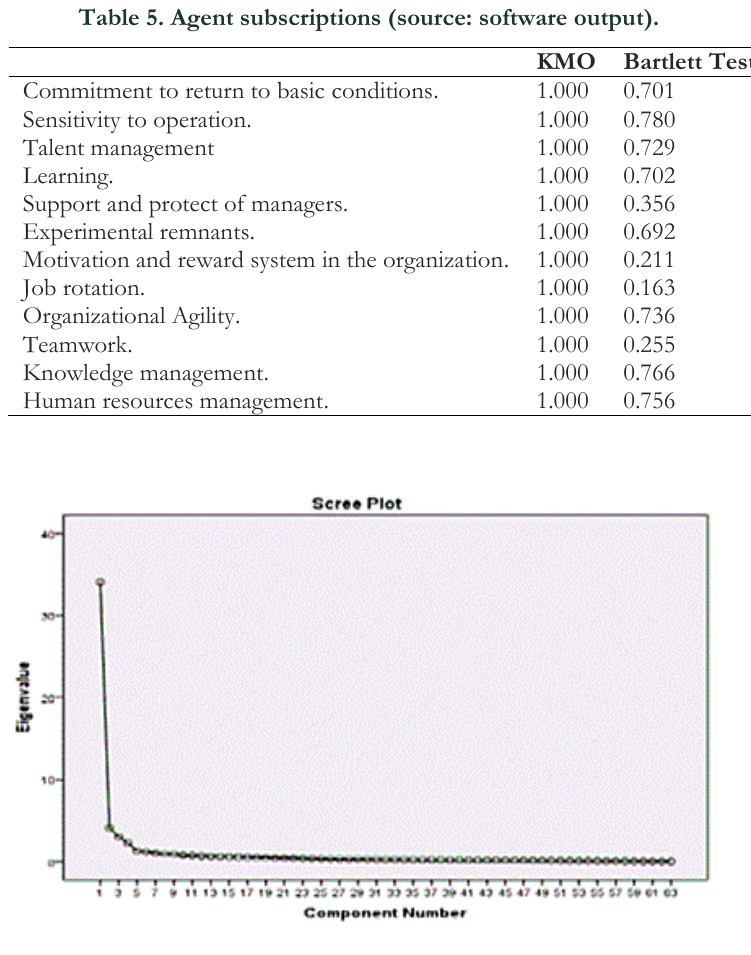
Fig. 2. Scray diagram for factor extraction (source: software